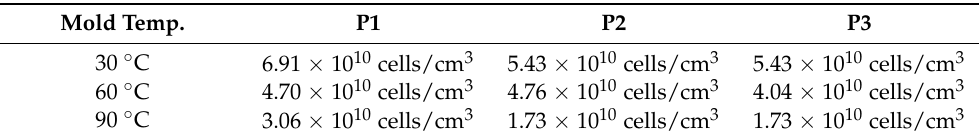
Table 4. Averaged cell density at different mold temperatures. Mold Temp.